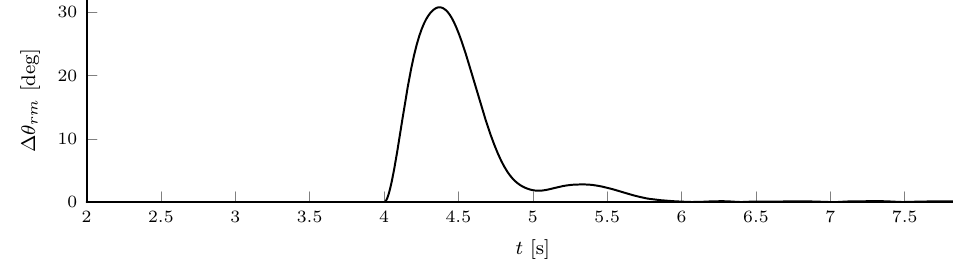
Figure 25. Normed angle difference; current-source control.